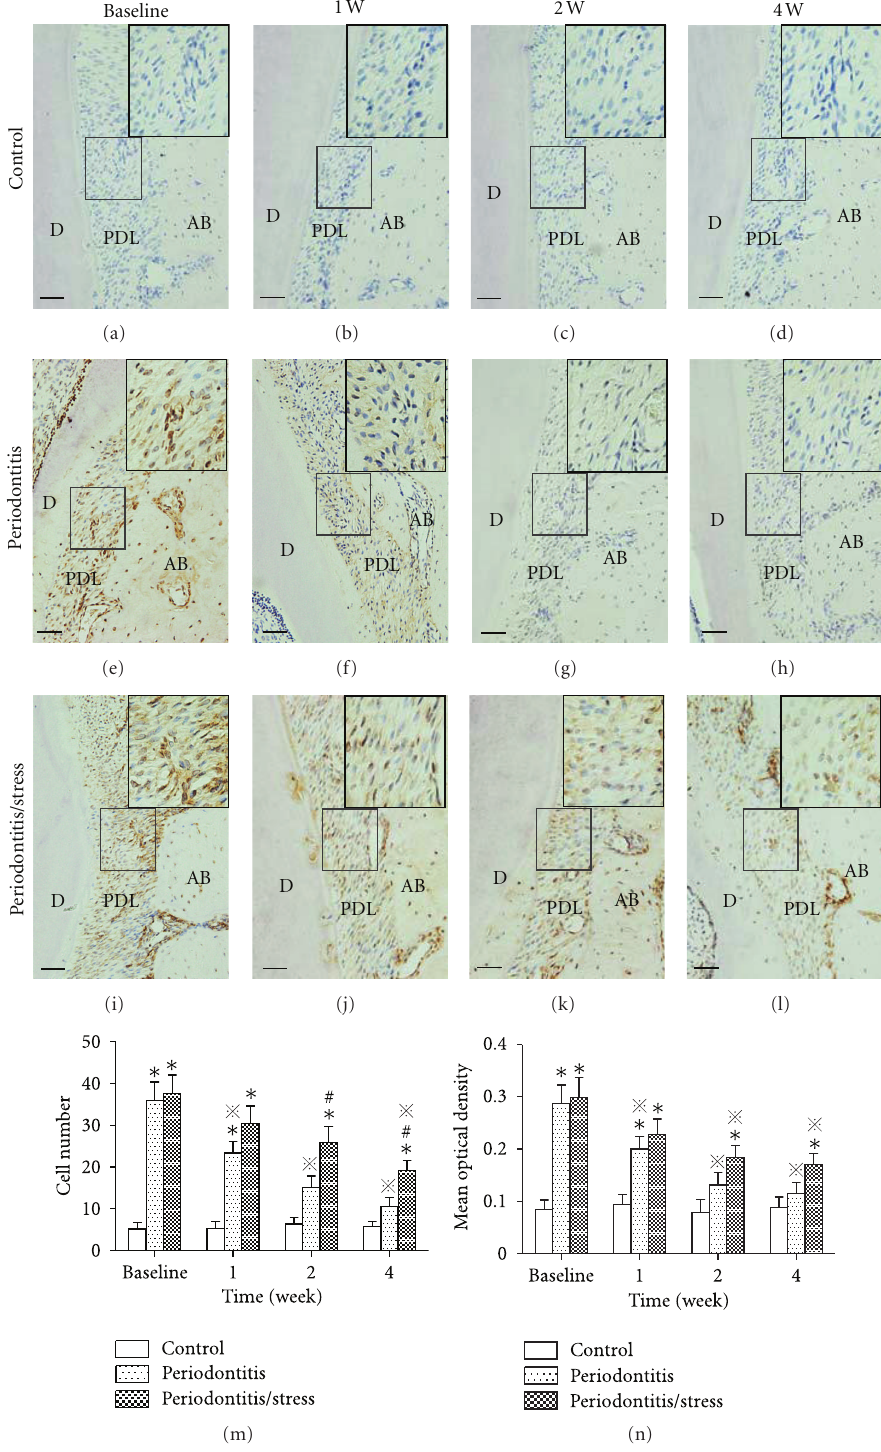
Figure 7: Immunostaining of tumor necrosis factor- α . ((a)–(l)) Area comprising the mesial root surface of the maxillary second molar of all groups at all time points (D: dentin, AB: alveolar bone, and PDL: periodontal ligament, indicate a higher magnification ( 400). (m)-(n)) Quantitative analysis of the number of immunoreactive cells (m) and the intensity of (cid:0) 0 . 05 versus the control group at the same time point. # P staining (n). (cid:0) P (cid:0) P 0 . 05 versus the same group at (cid:2)(cid:0) (cid:0)